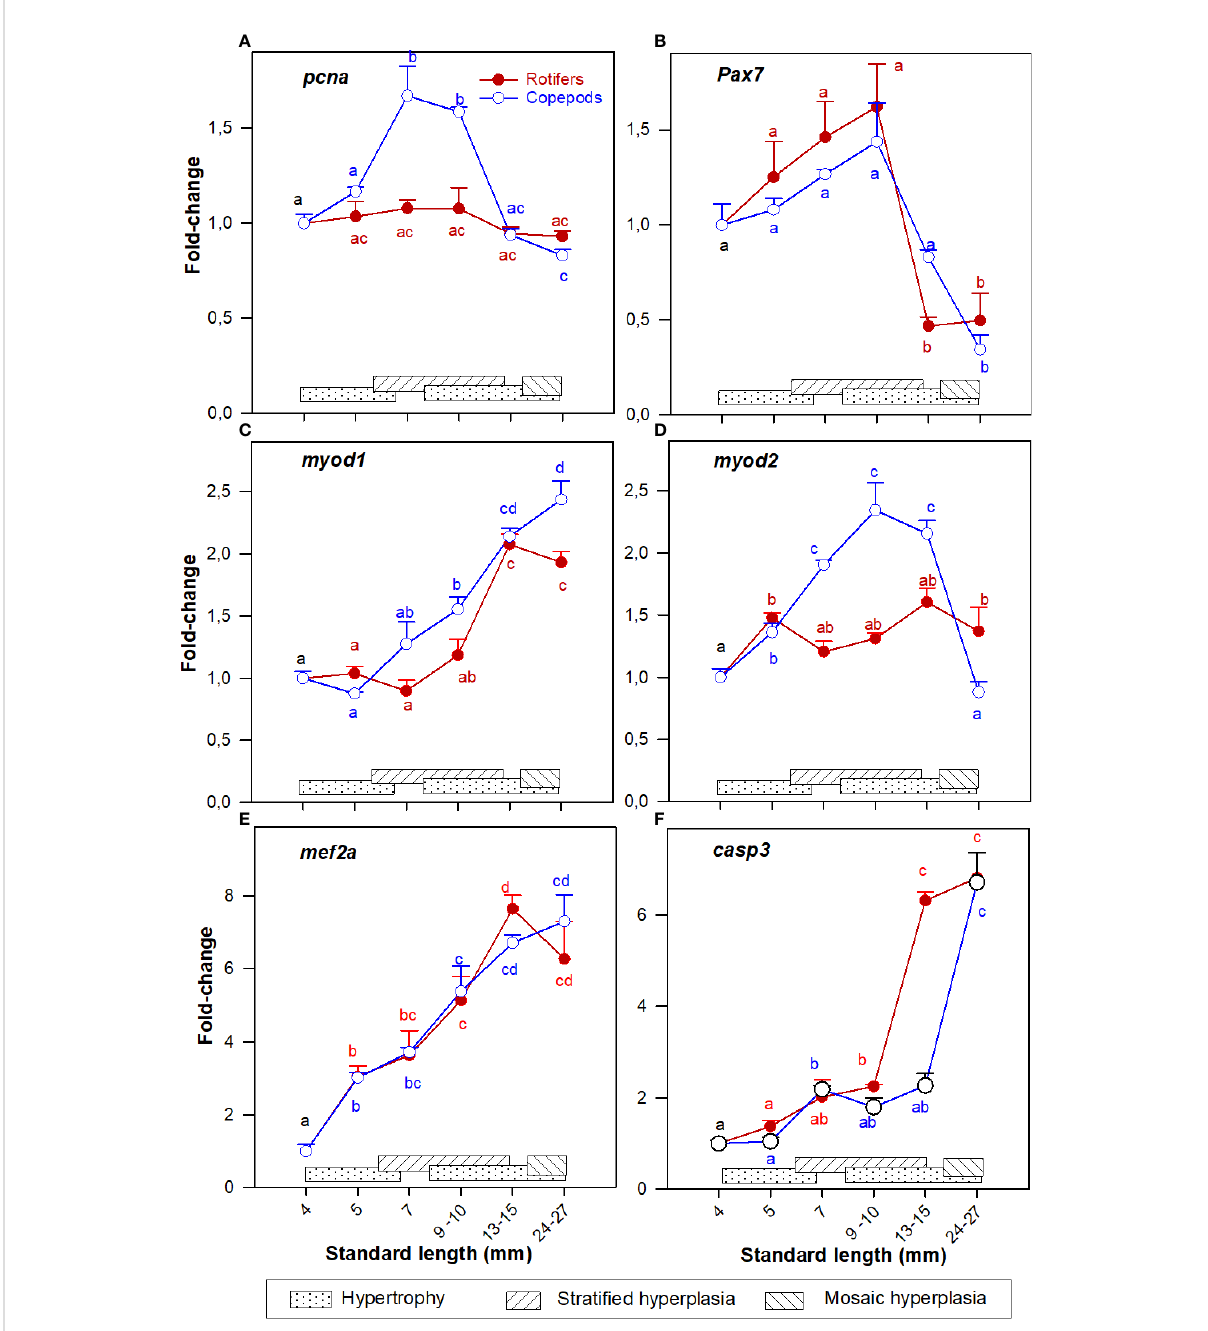
FIGURE 2 Gene expression (RNA-seq) of (A) pcna ; (B) pax7 ; (C) myod1 ; (D) myod2 ; (E) mef2a ; and (F) casp3 in whole-body Atlantic cod larvae fed rotifers/ Artemia (red line) or Copepods (blue line) in relation to muscle growth dynamics. Muscle growth dynamics (hypertrophy and strati fi ed and mosaic hyperplasia) in relation to body size is indicated by horizontal bars (data from Vo et al., 2016). Data are given as mean (n=3 [n= 4 at 4 dph] ± SEM) and values are expressed as fold change compared to day 4 post-hatch. Different letters indicate signi fi cant differences between the larval stages and treatments (P <